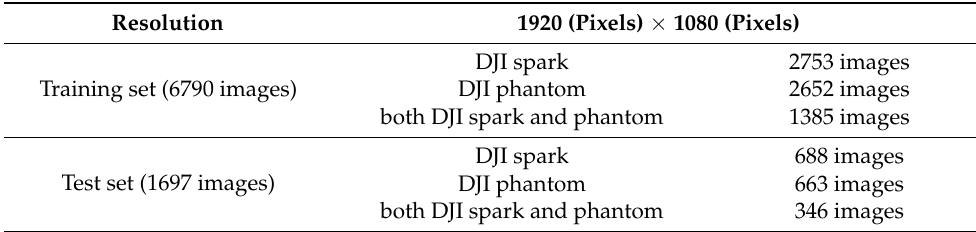
Table 1. Information on the UAV